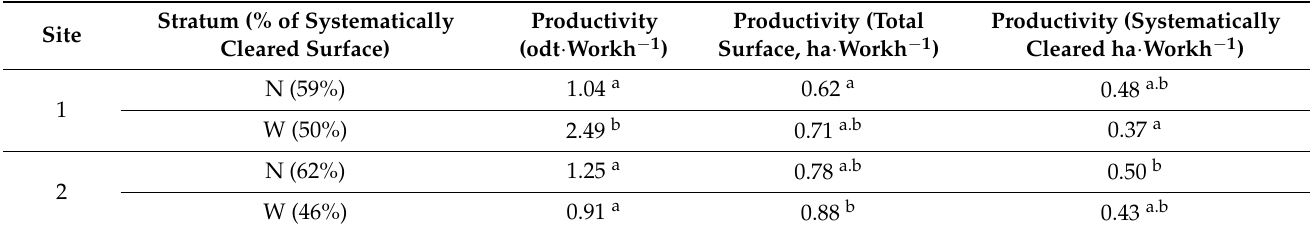
Table 4. Biobaler weight and surface productivity (the different superscript letters indicate statistically significant differences at 95% probability). Acronyms: N, narrow; W, wide; odt, oven dry tonne; Workh, workhour.